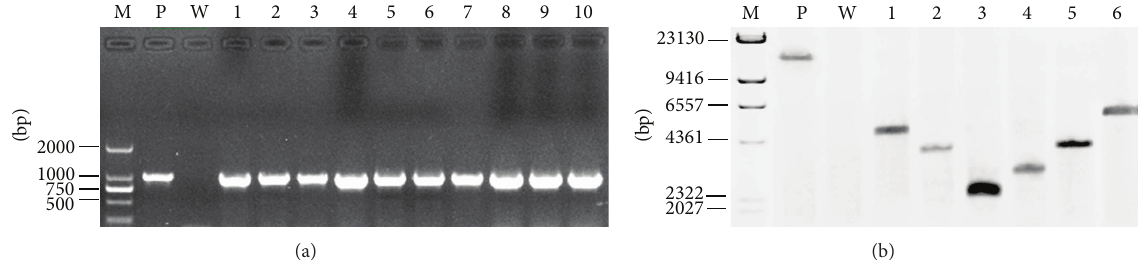
Figure 4: Molecular analysis of T-DNA integration into the genome of randomly chosen transformants resistant to hygromycin B. (a) Polymerase chain reaction assay with primers specific for the amplification of an internal 987 bp fragment of the hph gene. Lane P positive controlwithvectorpBIG3C,Wwild-type Valsamali LXS240101genomicDNA,Lanes1–10genomicDNAisolatedfromputativetransformants PFL1–PFL10, and M DNA molecular weight markers with bases indicated on the left. (b) Southern blot analysis of transformants with DIG- labeled hph gene probe. P positive control with vector pBIG3C linearized with Apa I, W wild-type Valsa mali LXS240101 genomic DNA digested with Hin dIII, 1–6 genomic DNA isolated from putative transformants PFL1-PFL6 digested with Hin dIII, and M DNA molecular weight markers with bases indicated on the left. These six transformants show single copy inserts and the insertion sites are different.